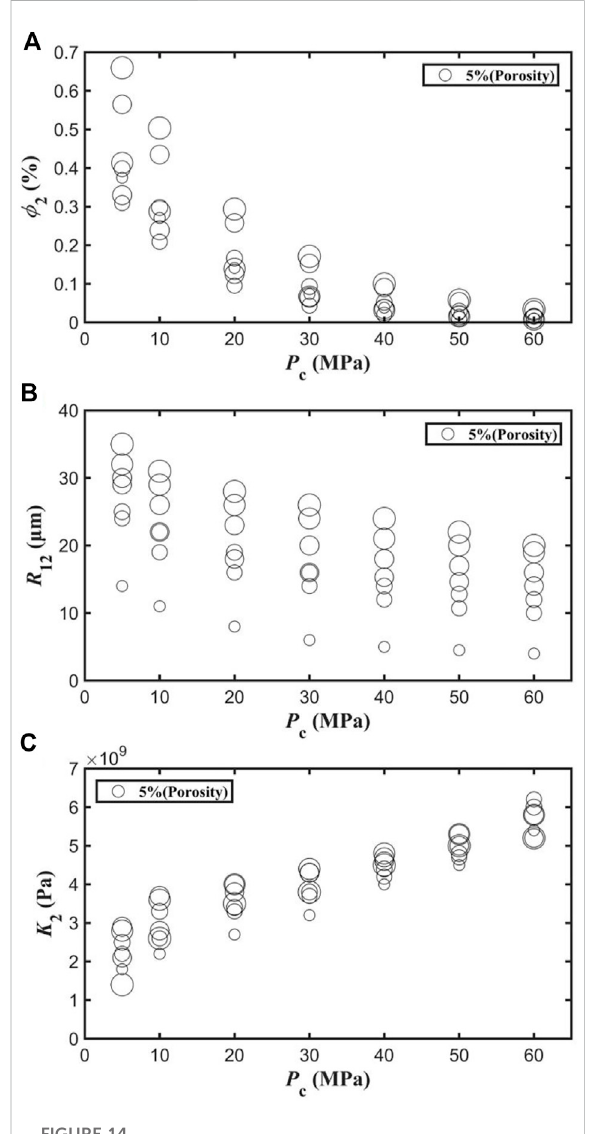
FIGURE 14 Crack porosity ϕ 2 (A) , inclusion radius R 12 (B) , and inclusion bulk modulus K 2 (C) as a function of con fi ning pressure for the seven rock samples (the size of the circles is proportional to porosity).